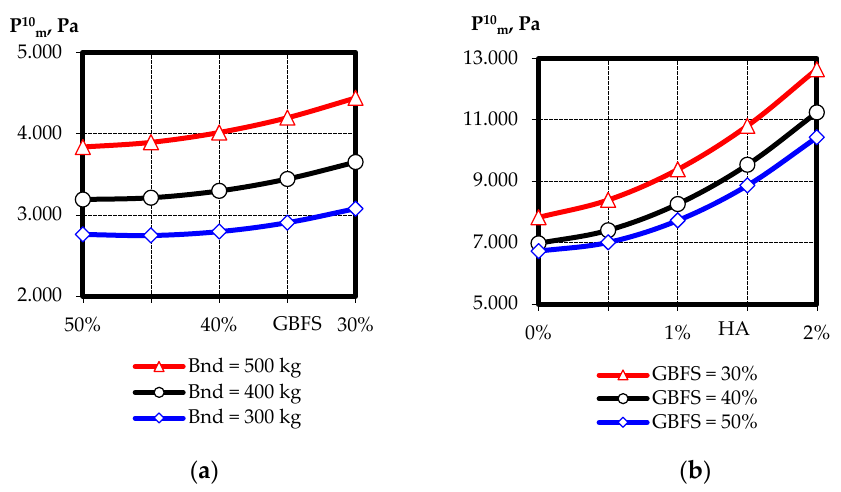
Figure 4. Graphical dependences of structural strength after 10 min ( a ) and 40 min ( b ) of mixture curing.